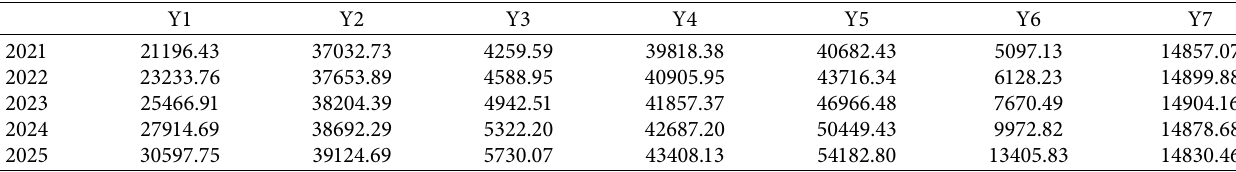
Table 11: Predicted values of economic